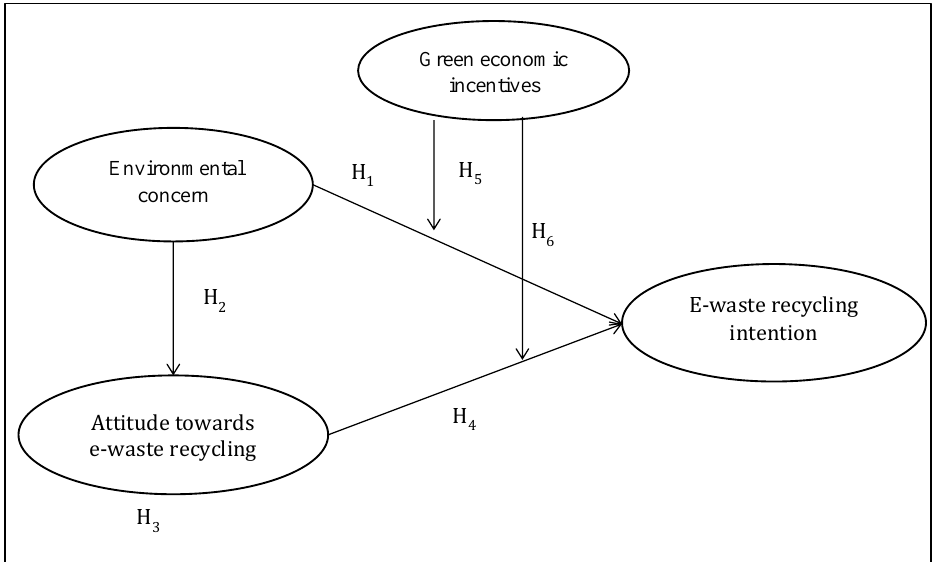
Figure 1: Proposed Conceptual